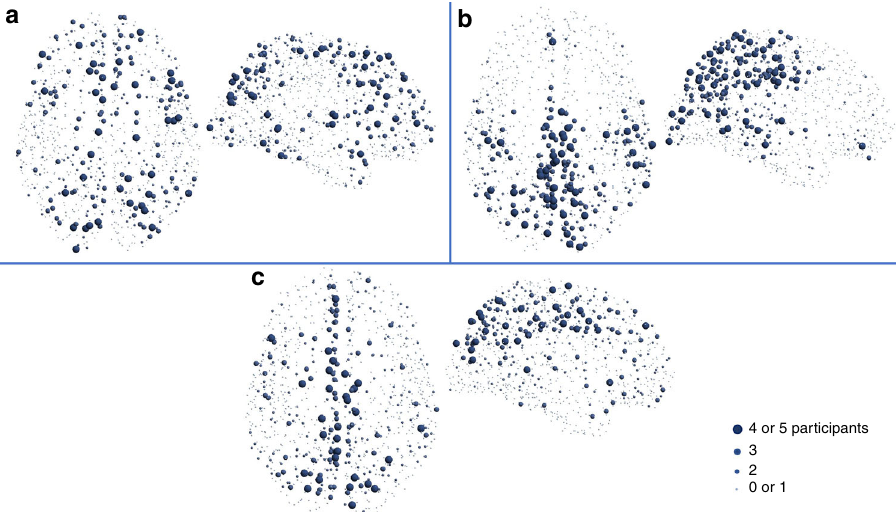
Fig. 1 Brain areas with the highest nodal measures appearing consistently across the participants, using high-resolution connectivity matrices (998 ´ 998) from Hagmann et al. 20 . The top 25% nodes are shown for curvature ( a ), strength ( b ), and betweenness centrality ( c ). For instance, the largest spheres indicate nodes with high values in 4 or 5 out of the fi ve